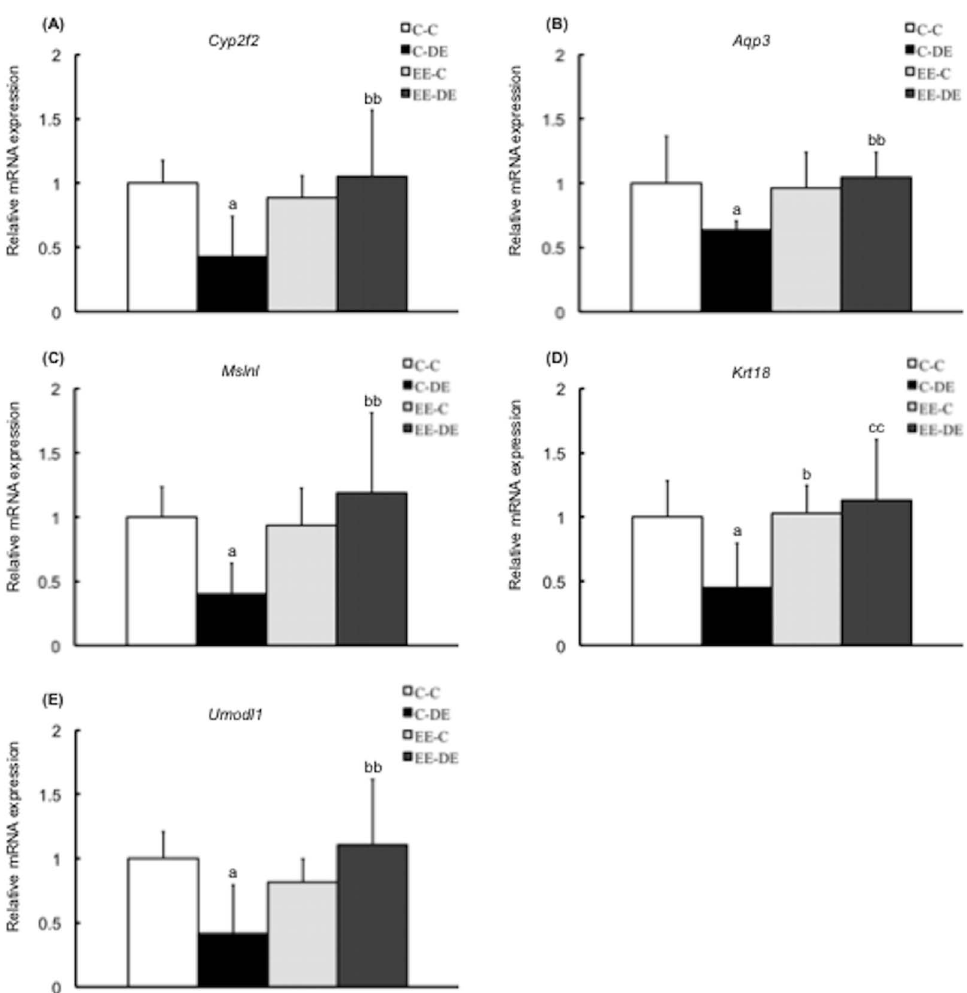
Figure 5. Confirmation of microarray data in cluster B by RT-PCR. Data show mRNA expressions for (A) Cyp2f2 , (B) Aqp3 , (C) Mslnl , (D) Krt18 , and (E) Umodl1 in the olfactory bulb of mice in each group. Cyp2f2 , Aqp3 , Mslnl , Krt18 , and Umodl1 of mice reared in a standard cage environment were significantly downregulated by exposure to diesel exhaust. There was no significant effect of exposure to diesel exhaust on gene expression of mice reared in environmental enrichment. The data are expressed as relative target gene expression compared with Gapdh expression. Each column represents the mean 6 standard deviation (C-C: n=7, C-DE: n=7, EE-C: n=8, EE-DE: n=9). Data were analyzed by two-way analysis of variance as described in the Methods section. An analysis of simple effects is as follows: Cyp2f2 : a indicates significant differences (Tukey-Kramer method, a P , 0.05, C-C vs. C-DE); b indicates significant differences (Tukey–Kramer method, bb P , 0.01, C-DE vs. EE-DE); Aqp3 : a indicates significant differences (Tukey–Kramer method, a P , 0.05, C-C vs. C-DE); b indicates significant differences (Tukey-Kramer method, b P , 0.05, C-DE vs. EE-DE); Mslnl : a indicates significant differences (Tukey–Kramer method, a P , 0.05, C-C vs. C-DE); b indicates significant differences (Tukey–Kramer method, bb P , 0.01, C-DE vs. EE-DE); Krt18 : a indicates significant differences (Tukey–Kramer method, a P , 0.05, C-C vs. C-DE); b indicates significant differences (Tukey-Kramer method, b P , 0.05, C-DE vs. EE-C); c indicates significant differences (Tukey–Kramer method, cc P , 0.01, C-DE vs. EE-DE); Umodl1 : a indicates significant differences (Tukey–Kramer method, a P , 0.05, C-C vs. C-DE); and b indicates significant differences (Tukey–Kramer method, bb P , 0.01, C-DE vs.